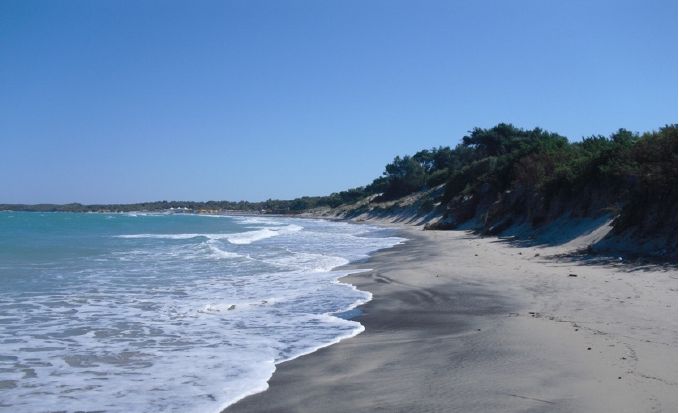
Figure 1. A photo of a vegetated dune on the beach of “Alimini” in Salento, Adriatic coast, southern Italy. Photo courtesy of Giuseppe Roberto Tomasicchio.